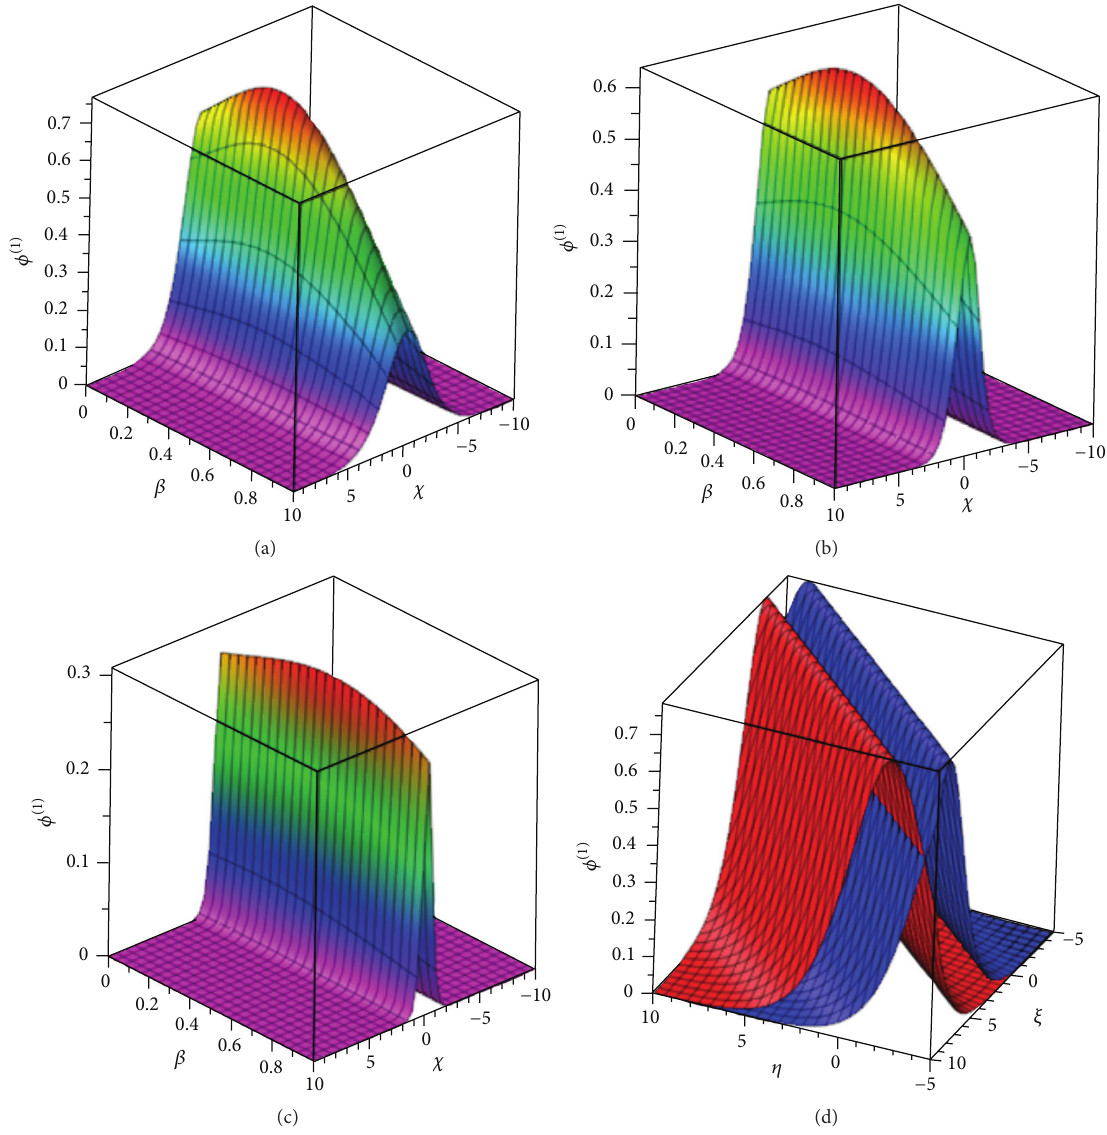
Figure 7: Variation of 𝜙 (1) with respect to 𝜒 and 𝛽 for the different values of thermal parameter and electron to positron temperature ratio, that is, (a) 𝑞 = 0.6 , 𝜎 = 1 , (b) 𝑞 = 1.6 , 𝜎 = 1 , and (c) 𝑞 = 0.6 , 𝜎 = 10 taking 𝛼 = 0.3 , 𝛿 = 0.01 , and 𝑉 = 0.75 . (d) Variation of 𝜙 (1) for 𝜏 = 5 and 𝜏 =